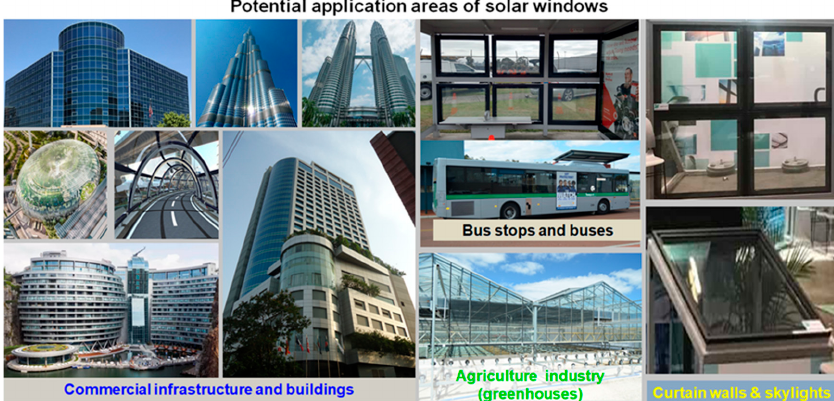
Figure 3. Highly transparent solar windows and their application areas. The solar window prototypes shown installed into an off-grid bus stop in Melbourne (Australia) are described in [55]; other solar windows shown in the right-hand side of the image are current products from ClearVue Technologies, showcased at Greenbuild Expo in Chicago, USA, in November